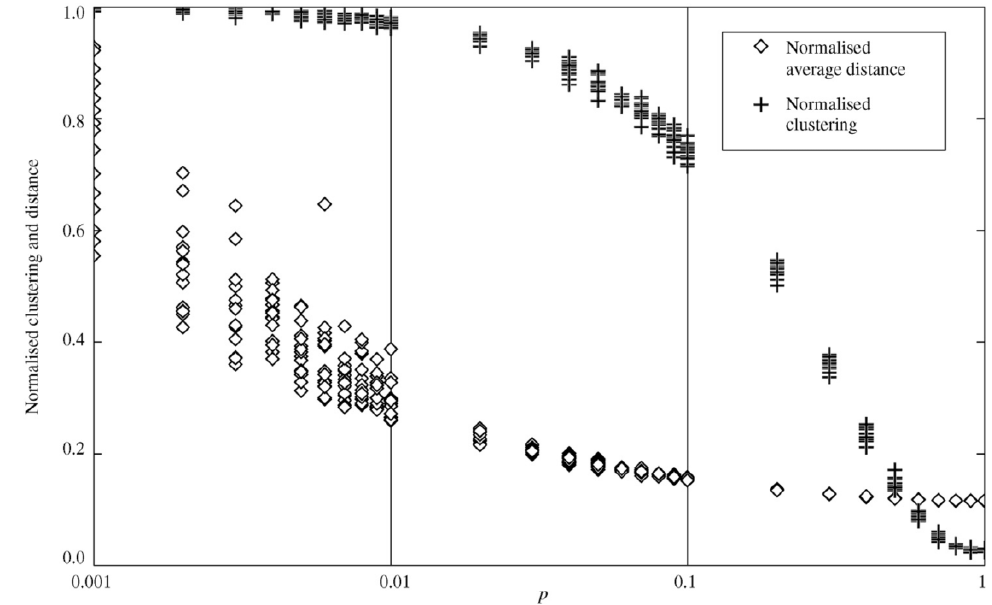
Figure 6. Relationship between average clustering coefficient, average path length and randomness p.